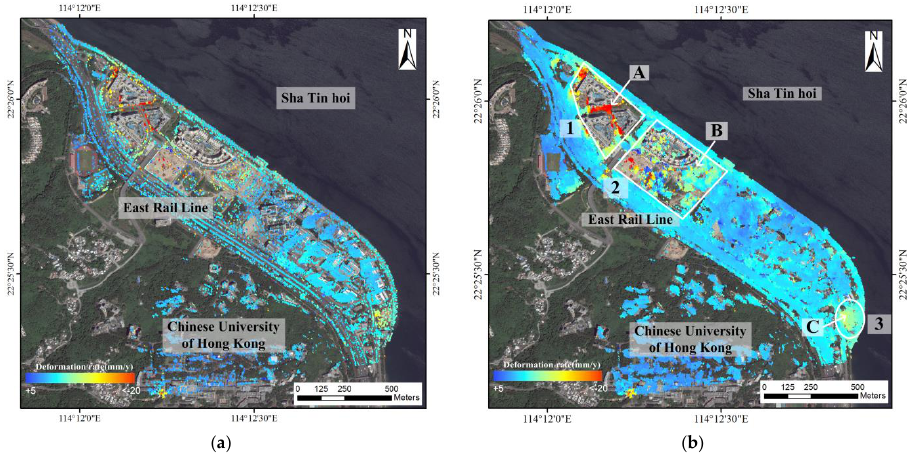
Figure 13. The LOS deformation velocity results of HKSP from TerraSAR-X Stripmap images retrieved by the PSI method ( a ) and the proposed DSI strategy ( b ).